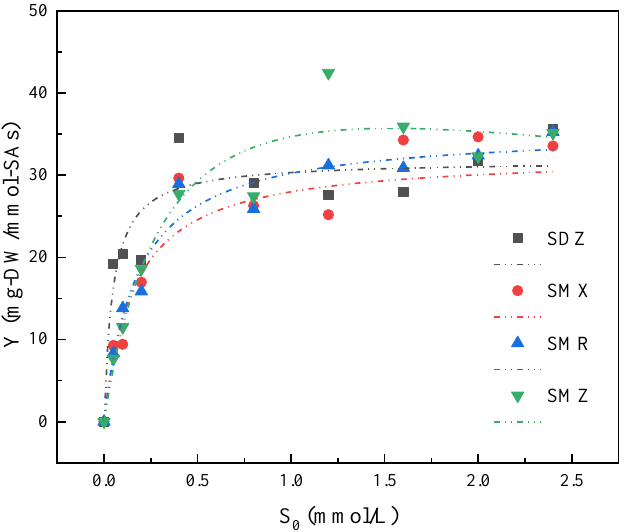
Figure 4. Biomass Yield coefficient for bacterial growth on initial SAs concentrations.